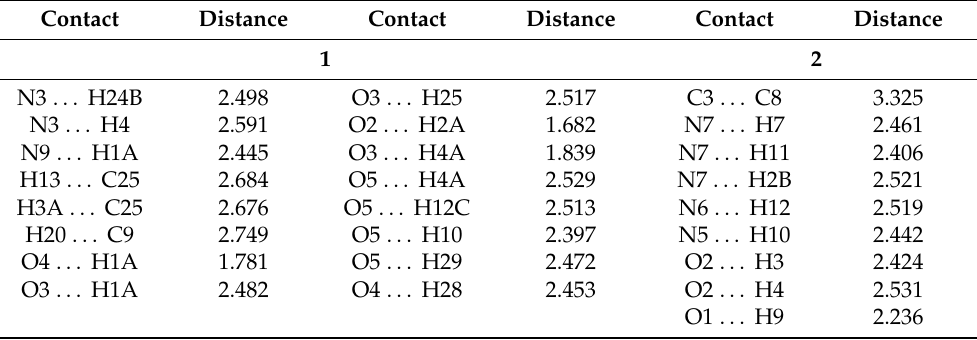
Table 6. Short distance contacts in compounds 1 and 2 .